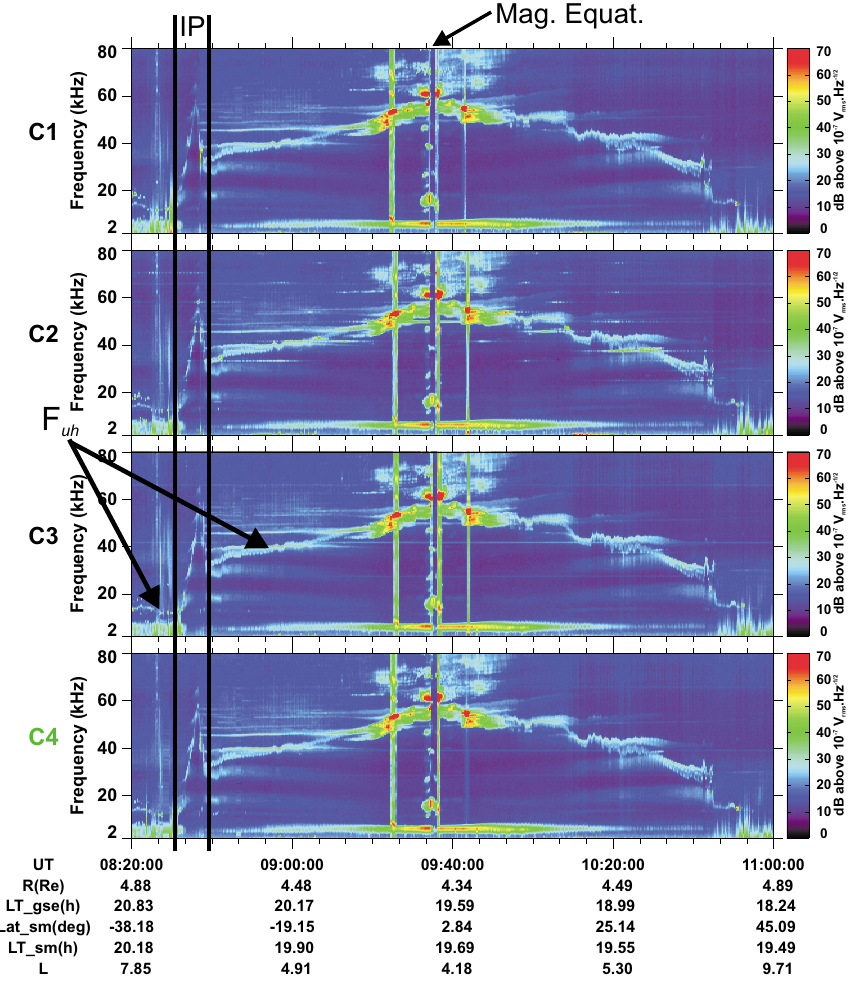
Fig. 2. Frequency-time spectrograms measured on 7 May 2002 by the WHISPER instrument onboard the four CLUSTER spacecraft. The entire plasmasphere crossing is shown, including a plume crossing during the inbound pass (IP) and the magnetic equator (Mag. Equat.) crossed at 09:35 UT. The upper hybrid frequency, F uh , is indicated by the black arrows. The orbital parameters correspond to